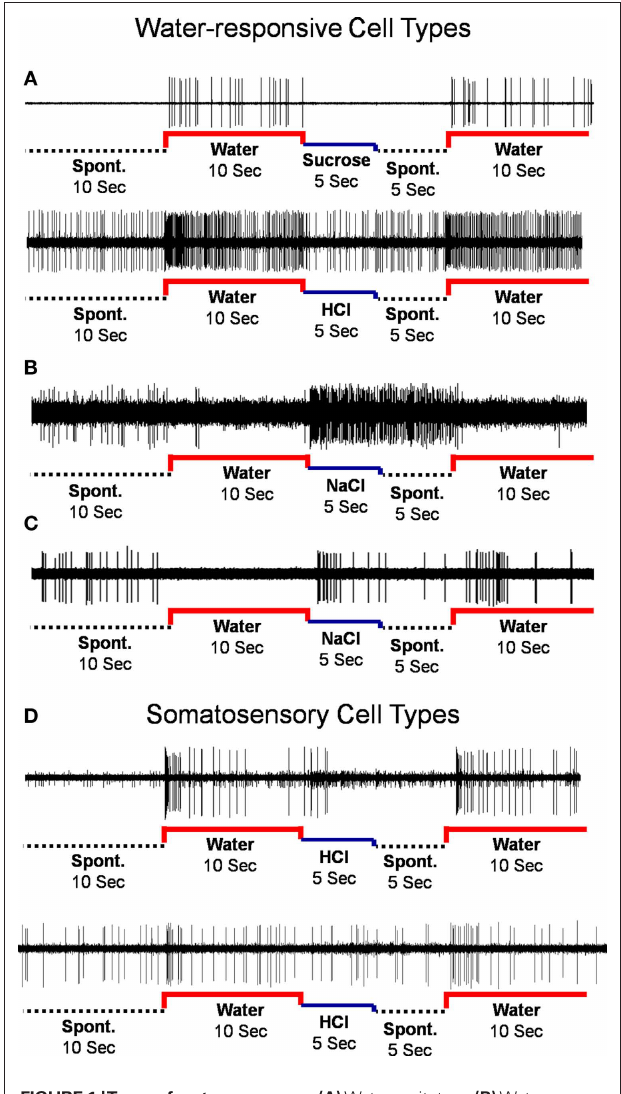
Figure 1 | Types of water responses. (A) Water-excitatory. (B) Water- inhibitory. (C) Conditional water. (D) Rapidly adapting (upper) and slowly- adapting (lower) somatosensory